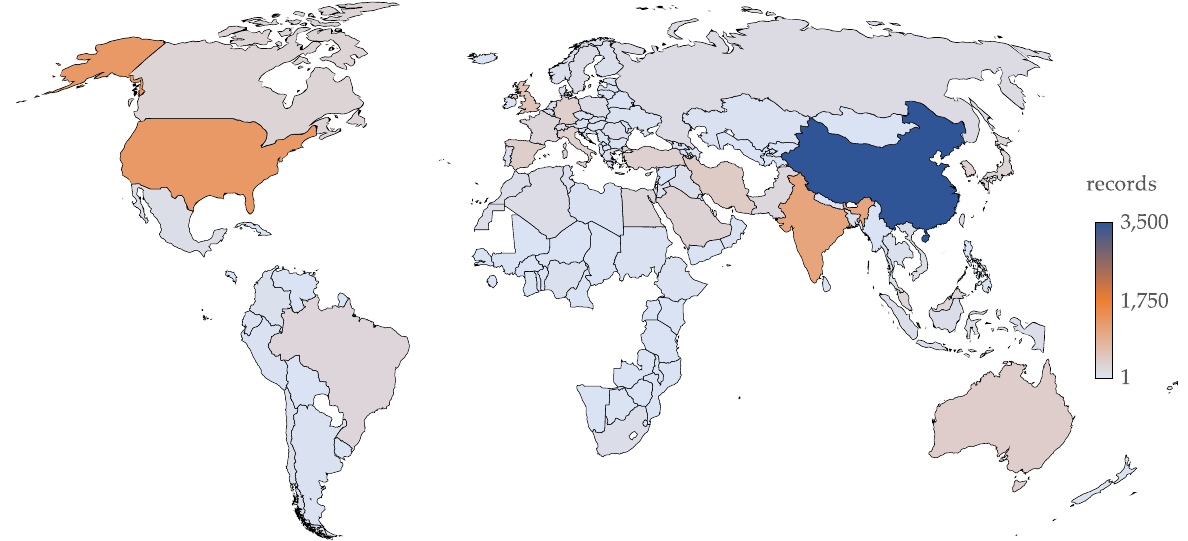
Figure 7. Most productive countries in terms of Solar Energy research in 2019–2020 (regions without publications have been omitted).